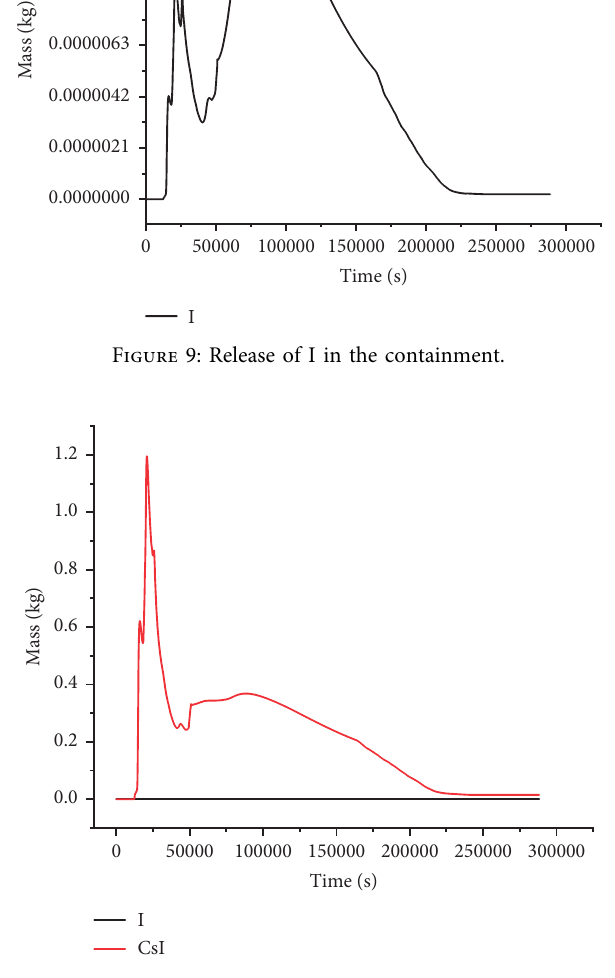
Figure 12: Release of CsI in the